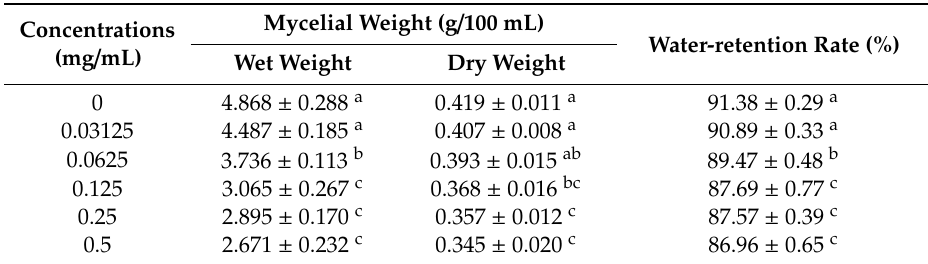
Values are mean ± S.E. The data followed by di ff erent letters within the column are significantly di ff erent according to Duncan’s test ( p <